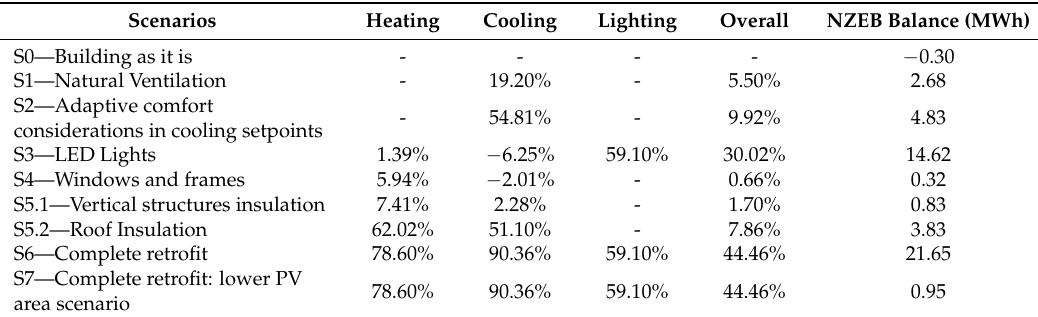
Table 1. Summary of the results for the retrofit